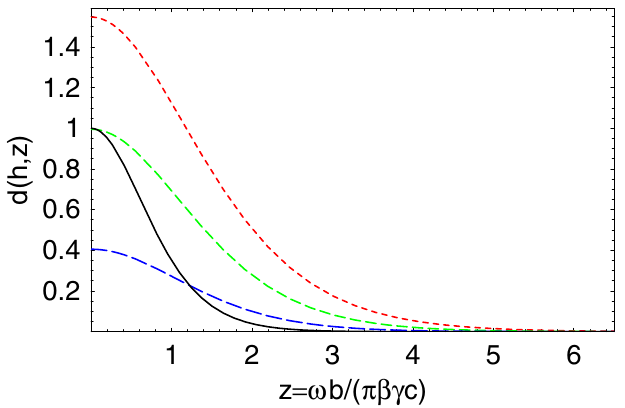
FIG. 4. (Color) Normalized magnitude of function d in Eq. (40) versus (cid:10)b=(cid:5) for three hole positions h (cid:5) y on the side wall of a square chamber (short-dashed, dashed, and long-dashed curves). The solid line shows for comparison (cid:2) (cid:10)b (cid:3) from Eq. (cid:10)b= 2 =I 1